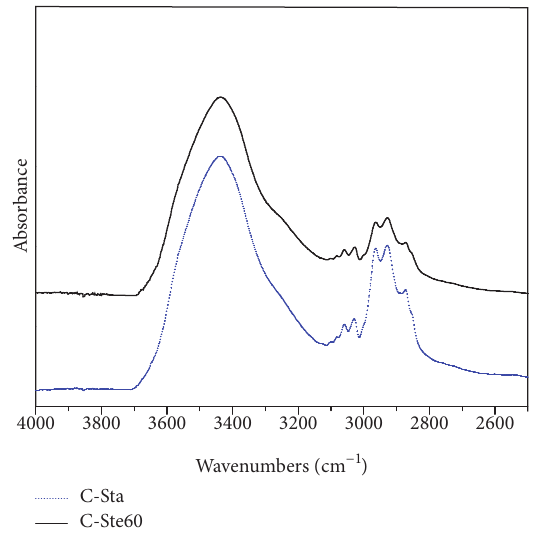
GFRP bars embedded in concrete Fitting curve of GFRP bare bars Fitting curve of GFRP bars embedded in concrete Figure 7: The change of tensile strength with curing